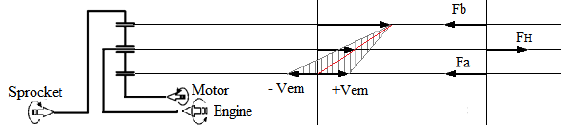
Figure 3. Equivalent battery circuit model